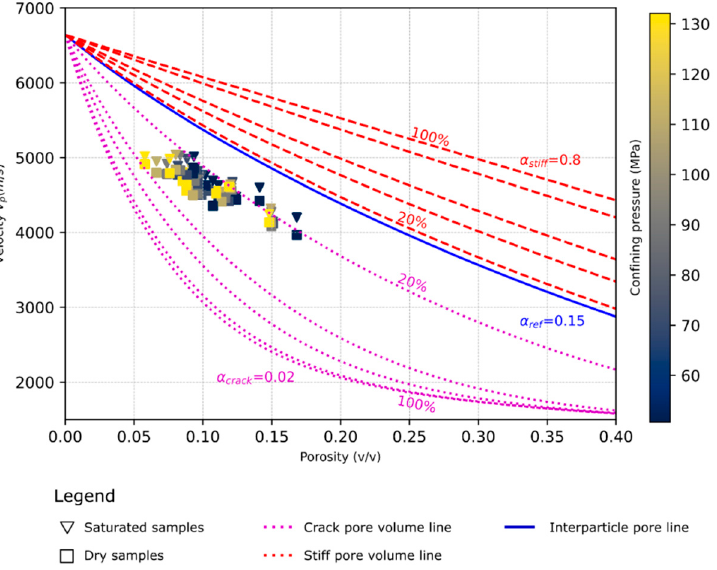
Figure 8. P-wave velocity and porosity crossplot with defined Xu-Payne model. Data are colored by value of effective pressure. Input elastic parameters are calcite: K = 76.8 GPa, μ = 32 GPa; water K = 2.1 GPa.